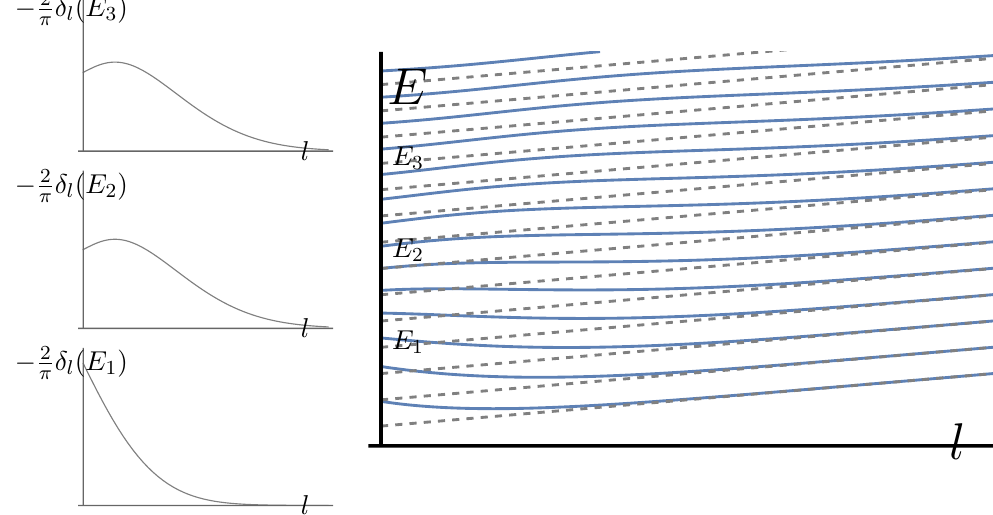
δ l as a function of l for three different π + 2 n + l 2